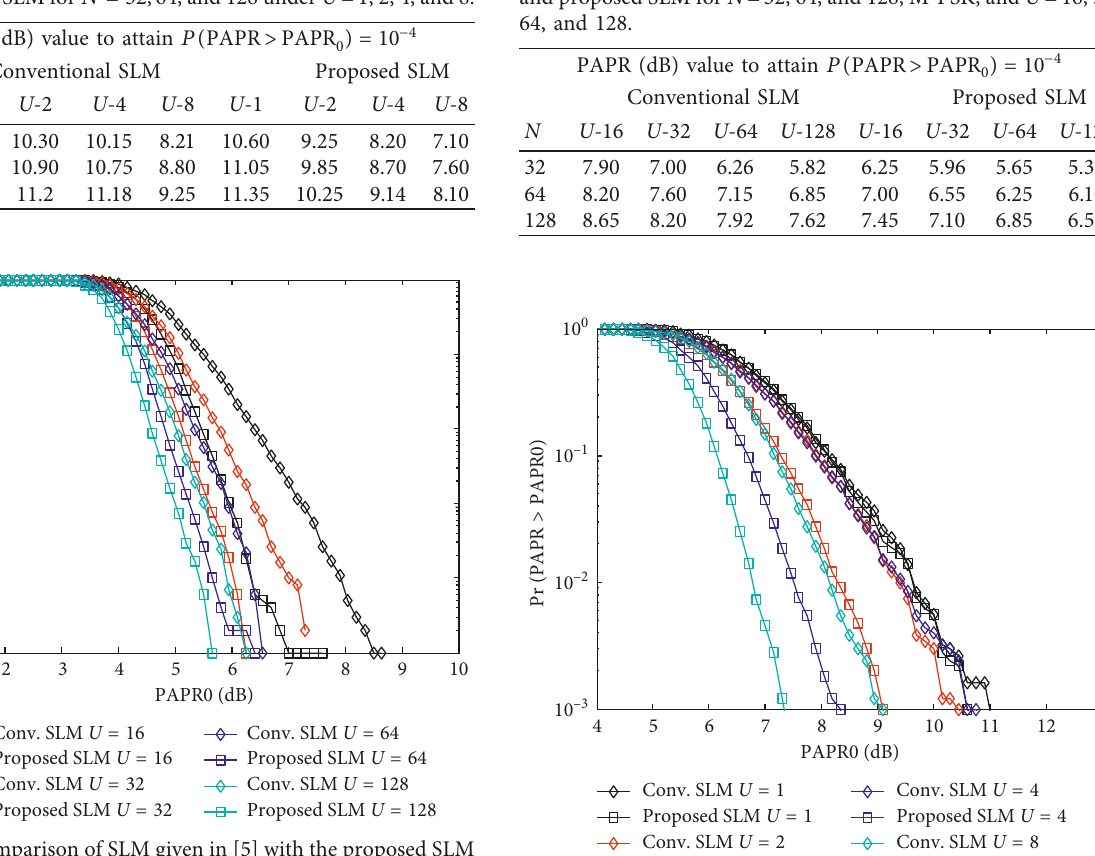
Table 2: CCDF performance investigation of conventional SLM and proposed SLM for N � 32, 64, and 128, M-PSK, and U � 16, 32,